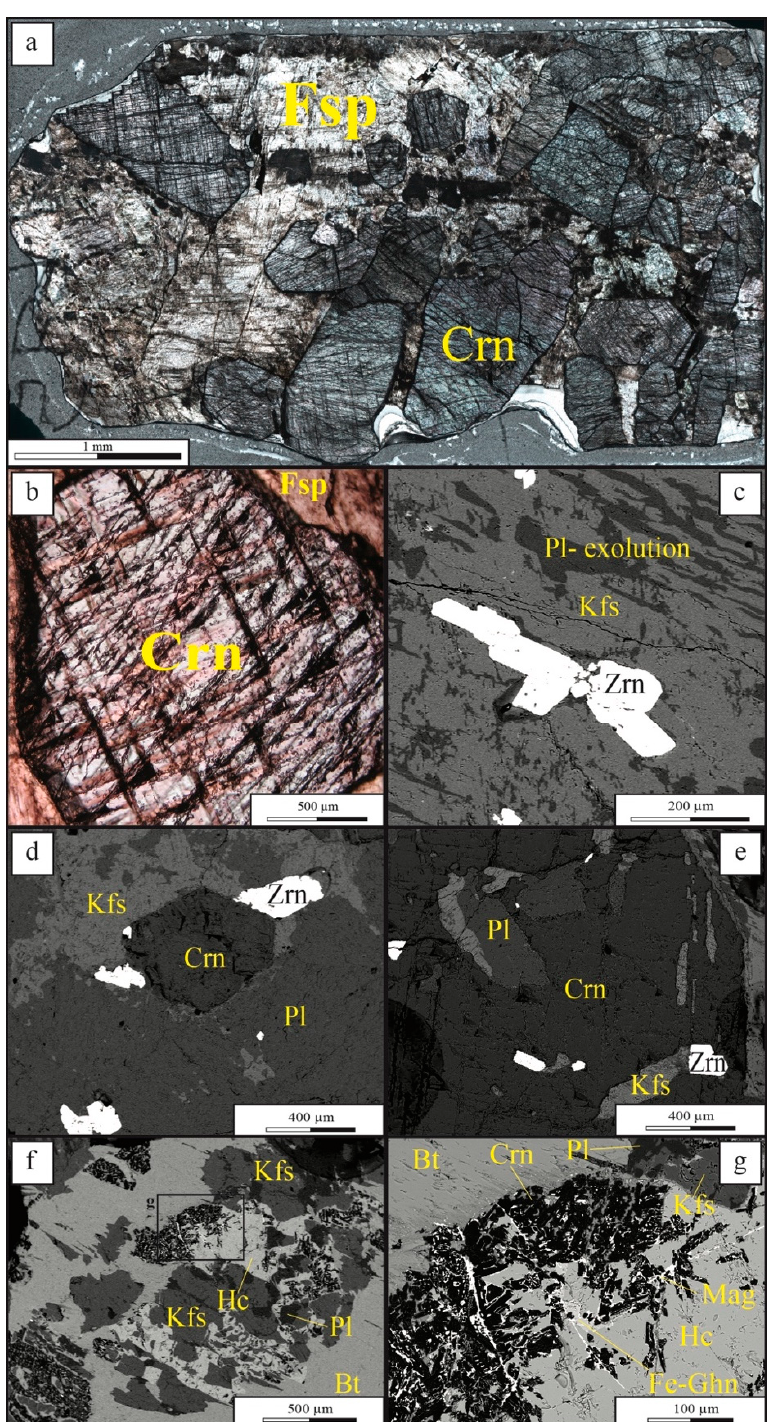
Figure 3. ( a ) Scan of SB09 thin section (80 μ m thick) showing the magmatic/pegmatitic texture of the sample. ( b ) photograph of a euhedral crystal of corundum. ( c ) SEM-backscattered electron (BSE) image showing K-feldspar crystal with plagioclase exsolution and inclusions of zircon cluster. ( d ) SEM-BSE image of the mineral assemblage consisting of plagioclase, K-feldspar, corundum and zircon. ( e ) SEM-BSE image of zircons, K-feldspar and plagioclase inclusions within corundum. ( f ) SEM-BSE image of poikilitic biotite hosting spinels, K-feldspar and plagioclase. ( g ) detail of ( f ) showing reaction along the contact between biotite and hercynite consisting of corundum, magnetite and Fe-gahnite.